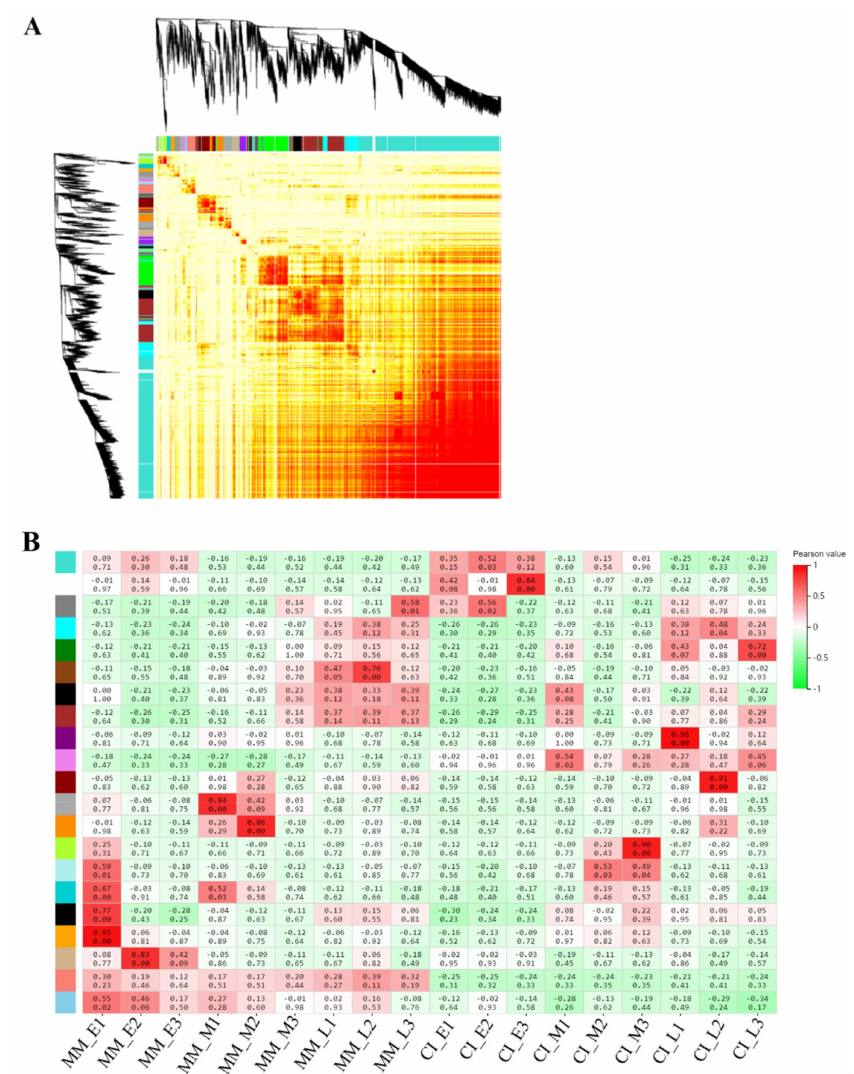
Figure 7. Weighted gene co-expression network analysis (WGCNA). ( A ) Different colors represent different gene modules, indicating different coefficients between genes. ( B ) Coexpression and correlations between the gene modules and phenotypes. The abscissa represents the samples; the ordinate represents the modules. The upper value in each cell represents the correlation coefficient, and the lower value represents the p -value.